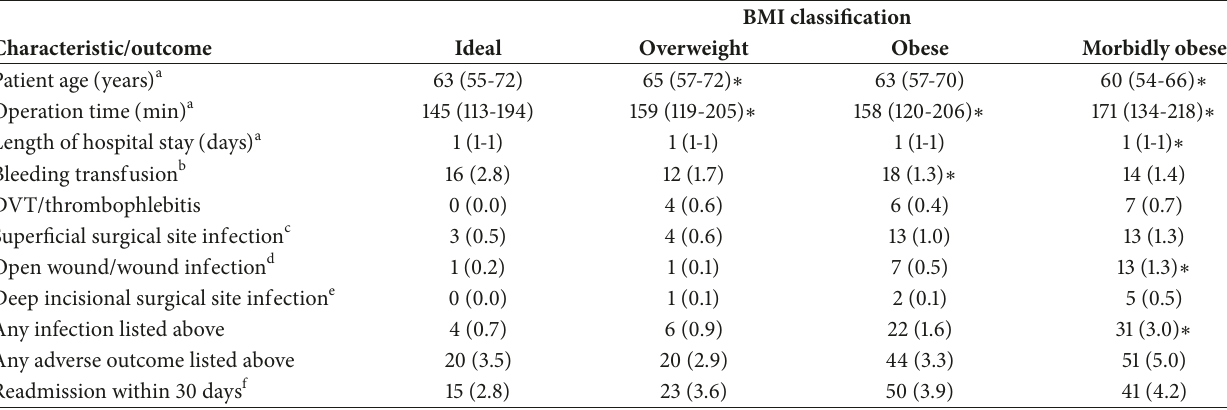
Table 3: Perioperative outcomes among uterine cancer patients undergoing total laparoscopic hysterectomy, stratified by patient’s body mass index, ACS-NSQIP,